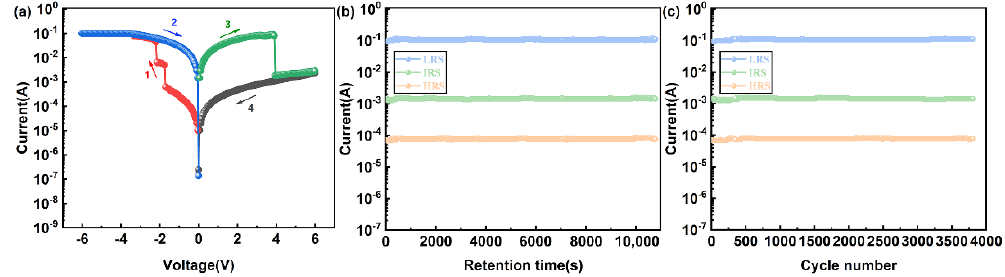
Figure 4. Cross-sectional SEM images of the devices based on different active layers: ( a ) pure PF- BBO and ( b ) PF-BBO/Au NPs.